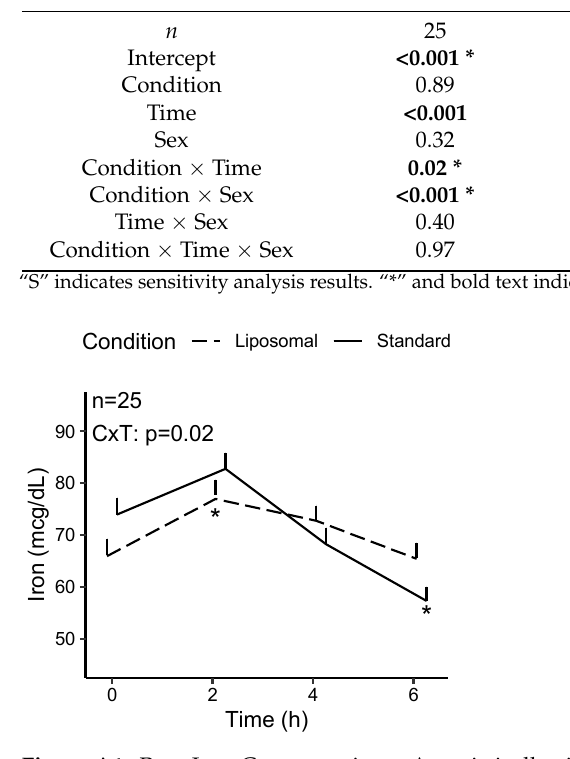
Figure A1. Raw Iron Concentrations. A statistically significant condition × time interaction was observed for raw iron concentrations ( p = 0.02; Table A1), uncorrected for baseline concentrations. Follow-up testing did not reveal significant differences between conditions at any individual time point ( p = 0.08 to 0.30). However, iron concentrations in the liposomal MVM condition increased from baseline to 2 h ( p = 0.03), but were not elevated relative to baseline at any subsequent time point ( p = 0.14 to p = 0.93). In contrast, within the standard MVM condition, the sole significant difference from baseline values was that the final observed value (6 h after MVM ingestion) fell below baseline values ( p = 0.001), unlike in the liposomal condition ( p = 0.93). Due to variation in raw baseline concentrations between conditions, the raw changes presented above are viewed as supplemental/secondary, while changes from the baseline and pharmacokinetic parameters (i.e., iAUC) were the primary outcomes. “*” indicate statistical significance (i.e., p < 0.05).